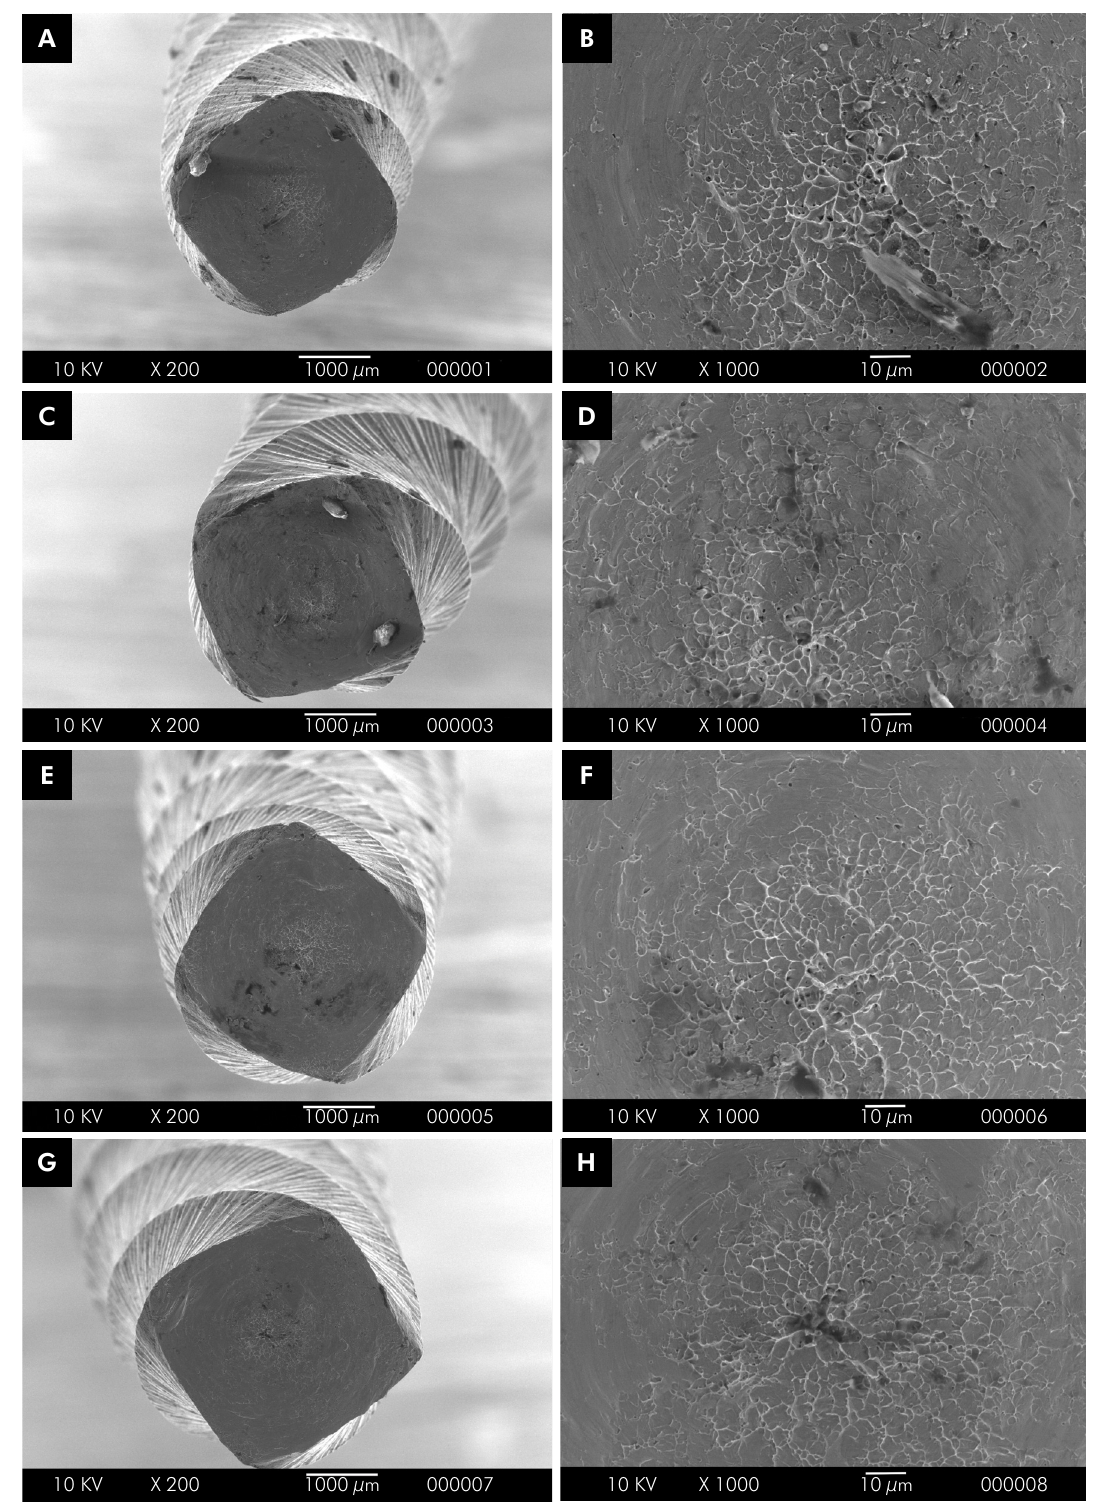
Figure 2. SEM images of separated fragments of unused A, B and used C, D reciprocating, and of unused E, F and used G, H rotary instruments after torsional fatigue testing. The first column shows the front view of the fragments with the circular box indicating the concentric abrasion mark at 200X magnification; the second column shows the concentric abrasion mark at 1000X magnification; the skewed dimples near the center of rotation are features typical of torsional failure for all instruments.